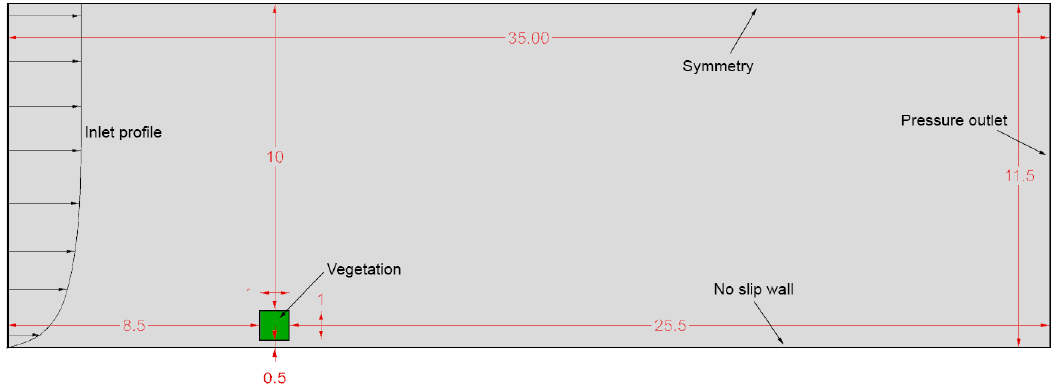
Figure 7. Simulation domain of the validation model, with the porous vegetation indicated by the green square and centred along the x -axis.